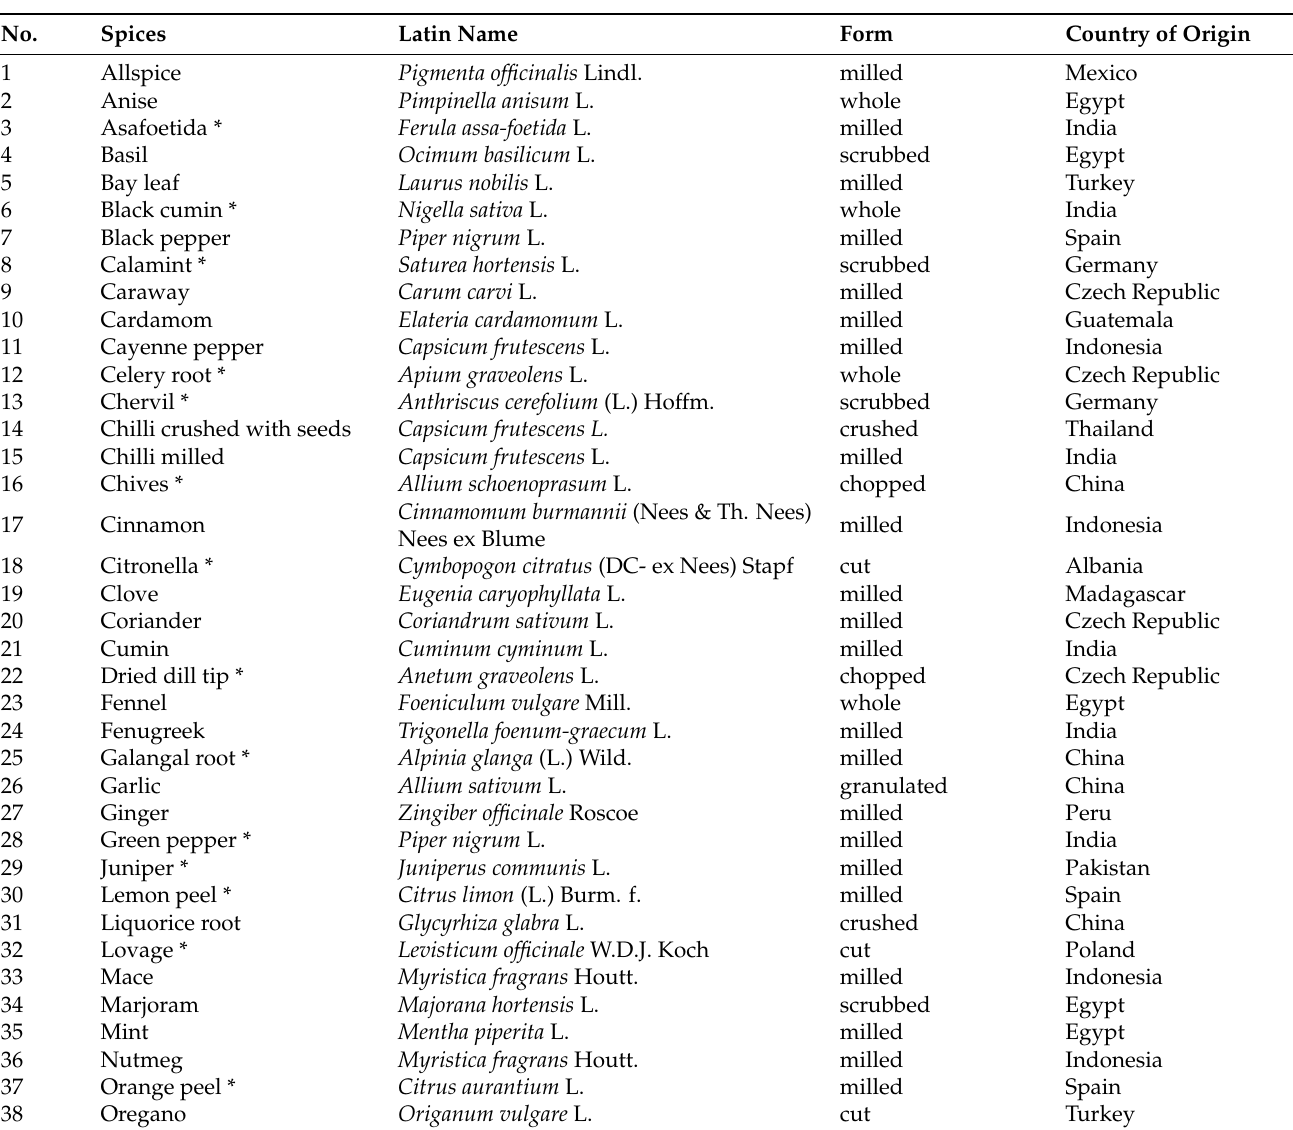
Table 2. The characterisation of spice